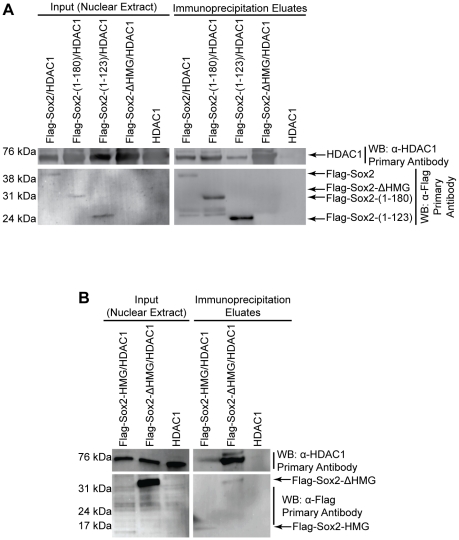
Domains of Sox2 used for association with HDAC1.(A) Mapping domains of Sox2 that mediate its association with HDAC1. 293T cells were transiently transfected with an expression construct for HDAC1 and the Sox2 constructs shown, and nuclear extracts were prepared 1 day later. Nuclear extracts (input lanes) used for co-immunoprecipitation of HDAC1 are presented as western blot analyses, probing for HDAC1 (top-left) or the Flag-Sox2 constructs indicated (bottom-left). M2-beads were used to co-immunoprecipitate the Flag-Sox2 constructs and their associated proteins. Immunoprecipitate eluates were used for western blots (right panels), and were probed for either HDAC1 (top-right) or the Flag-Sox2 constructs (bottom-right). (B) Co-immunoprecipitation of HDAC1 by Flag-Sox2-HMG or Flag-Sox2-ΔHMG. Experimental design was the same as described for Figure 3A. The experiments described were repeated, and similar results were observed.